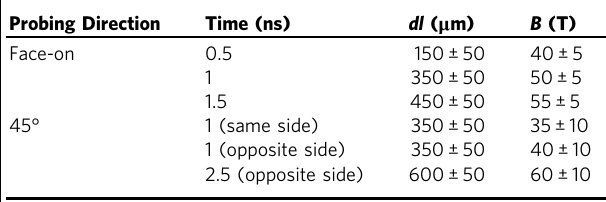
Table 2 Magnetic fi elds calculated from experimental